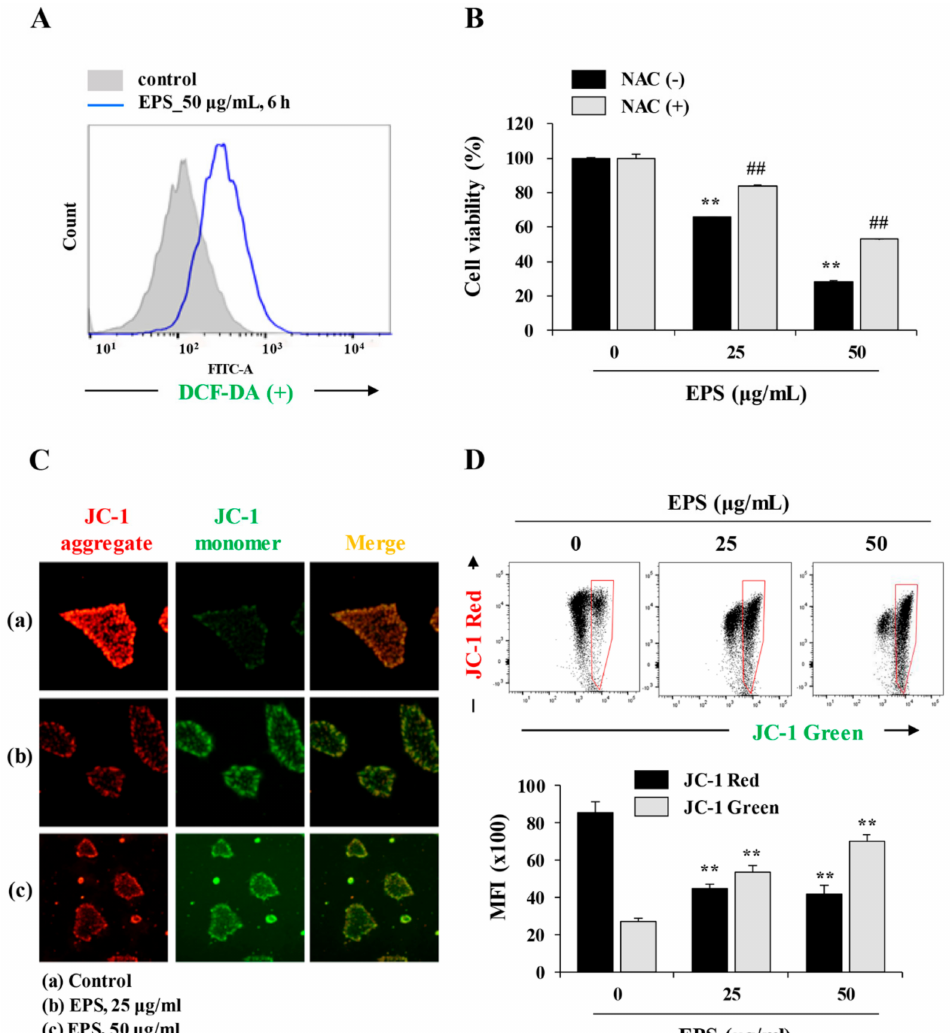
Figure 4. EPS increases intracellular ROS levels and induces loss of mitochondrial membrane potential (MMP). ( A ) hiPSCs were treated with 50 µ g / mL EPS for 6 h. After treatment with 5 µ M 2 (cid:48) 7 (cid:48) -dichlorofluorescein diacetate (DCF-DA) for 30 min, the intracellular ROS levels were measured using flow cytometry. ( B ) hiPSCs pre-treated with or without 50 µ M N-acetyl-L-cysteine (NAC) for 30 min were treated with 25 and 50 µ g / mL EPS. After 24 h, cell viability was assessed using